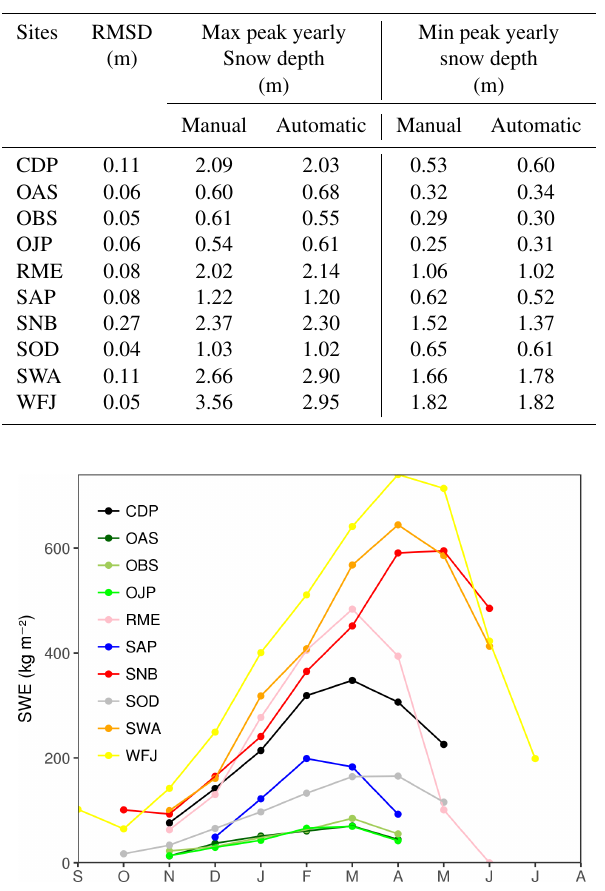
Table 3. Root-mean-square difference between manual and auto- matic snow depth measurements, maximum yearly snow depth, and minimum yearly snow depth for all sites.